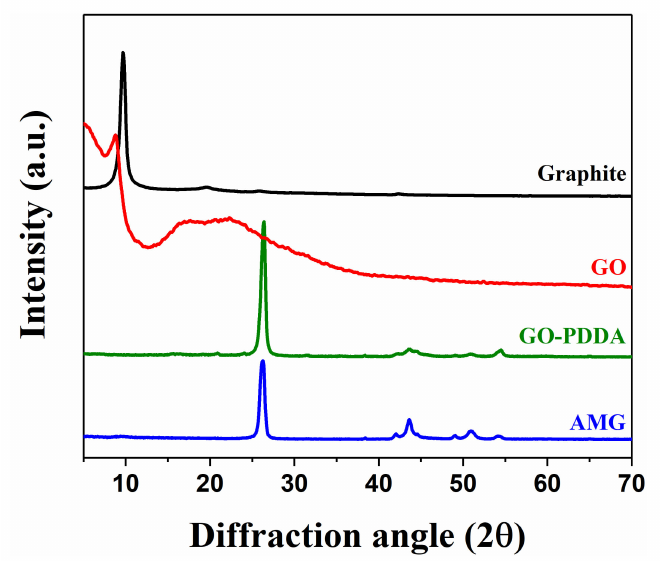
Figure 3. XRD analysis of graphite, GO, GO-PDDA, and